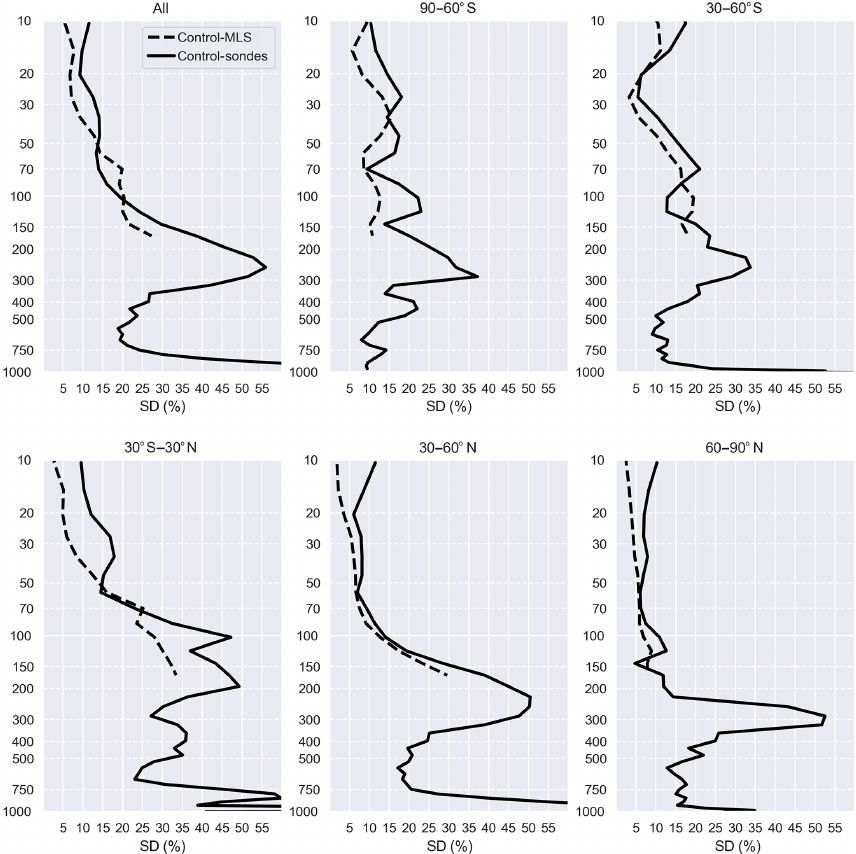
Figure 5. Relative standard deviation of the control simulation with respect to radiosoundings (solid lines) and MLS (dotted lines). Same plots as in Fig. 3.